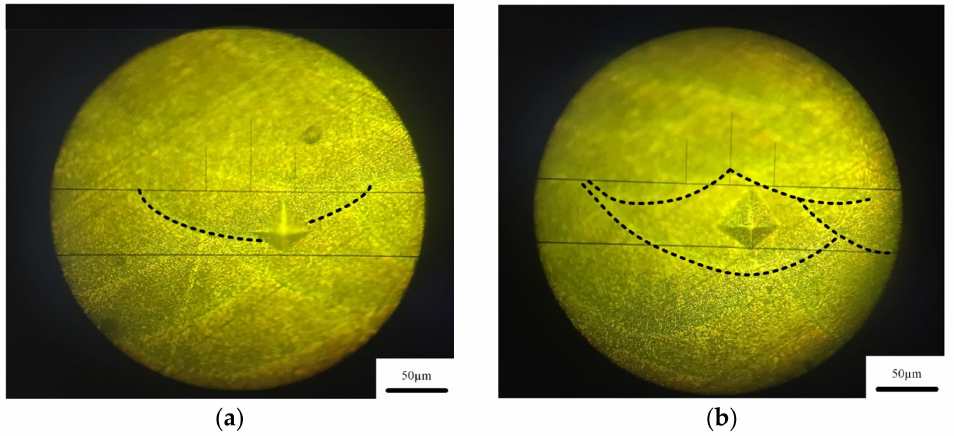
Figure 13. Microstructure of deposited state hardness test. ( a ) melt pool boundary, ( b ) melt pool.